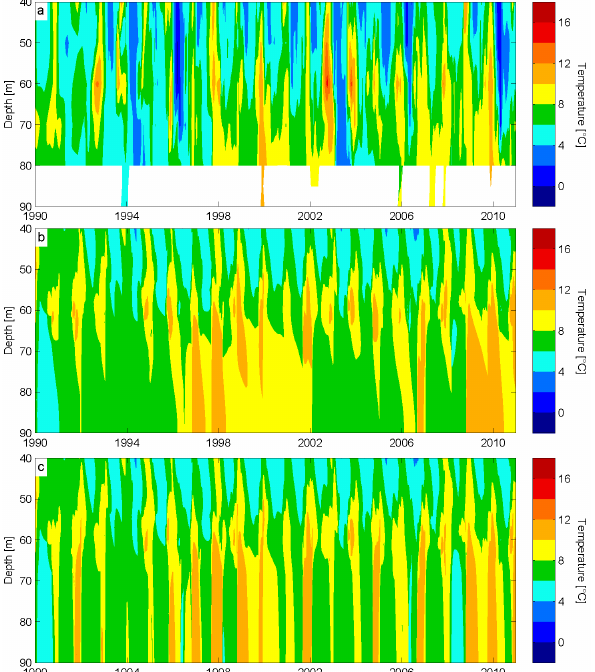
Figure 6. (a) The measured temperature from BY4, (b) the modeled temperature (reference run) and (c) the modeled temperature when pumping 1000m 3 s − 1 from 30m depth down to 90m.